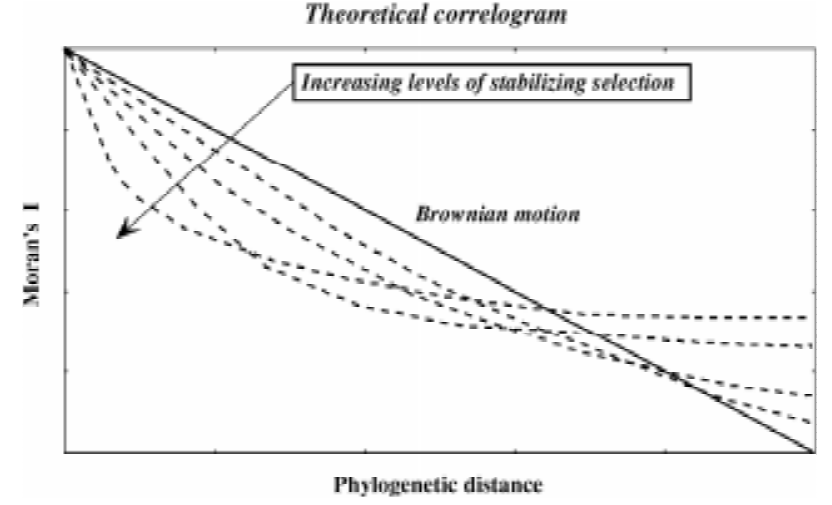
Figure 6 - Theoretical correlograms showing how increasing levels of stabilizing selection (in O-U process) distorts the monotonic correlogram that is expected under a Brownian motion. Curved dashed lines indicate different levels of stabilizing